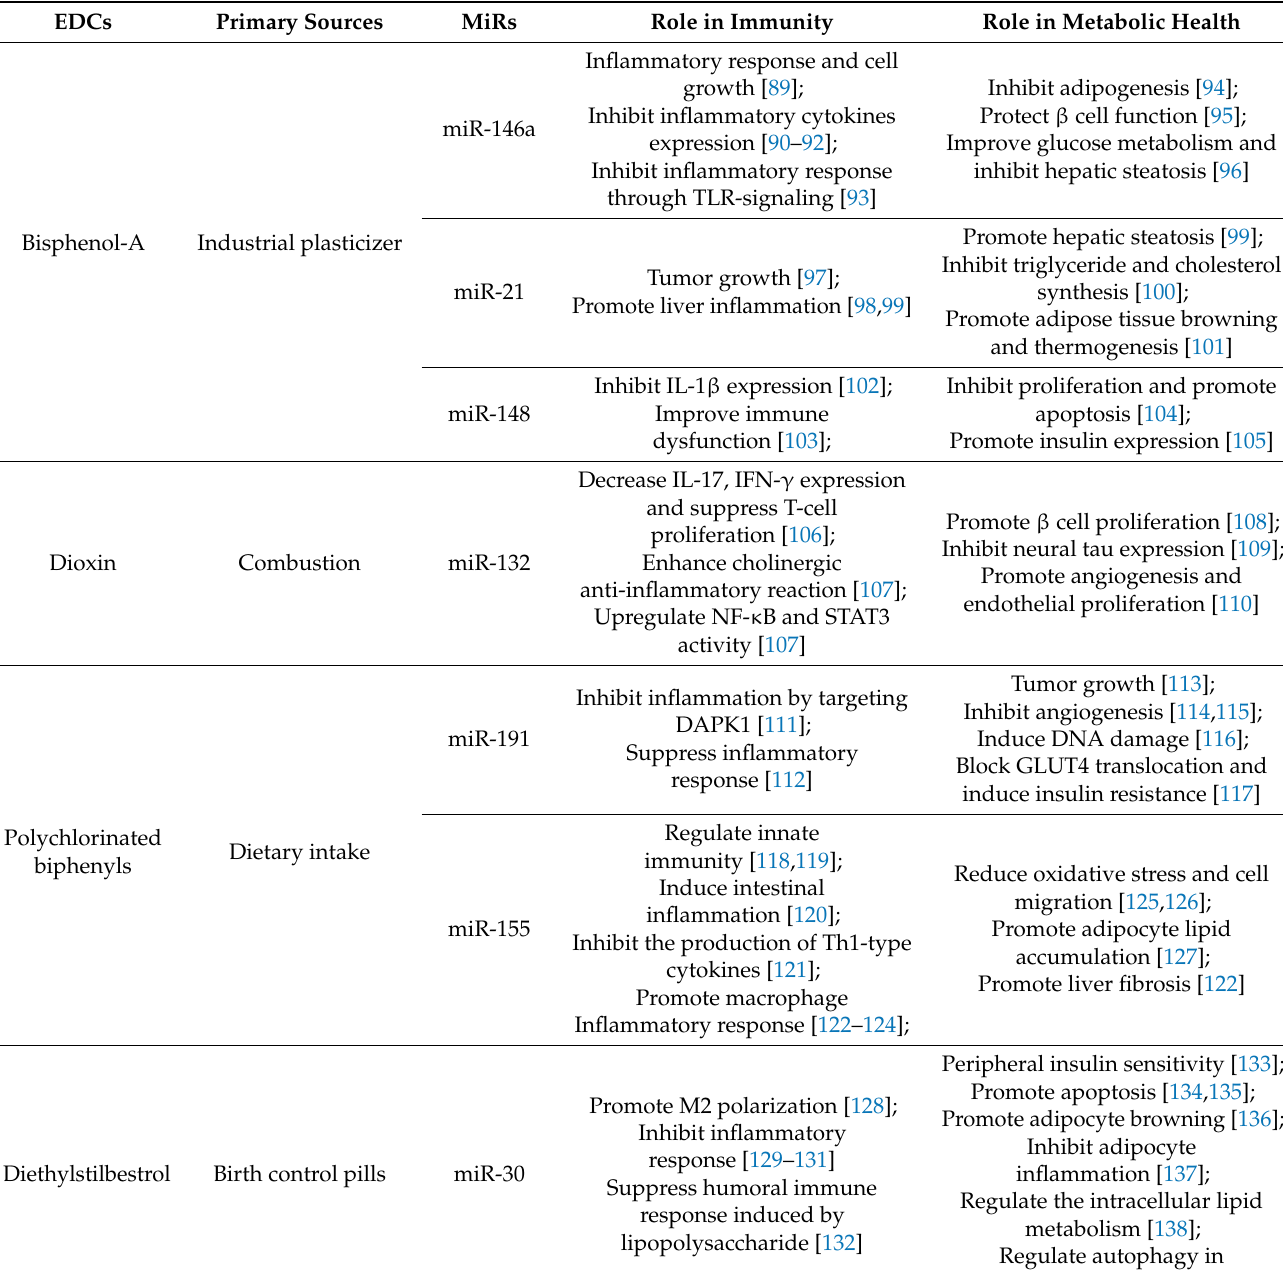
Table 1. MiRs affected by EDCs and their role in immune and metabolic